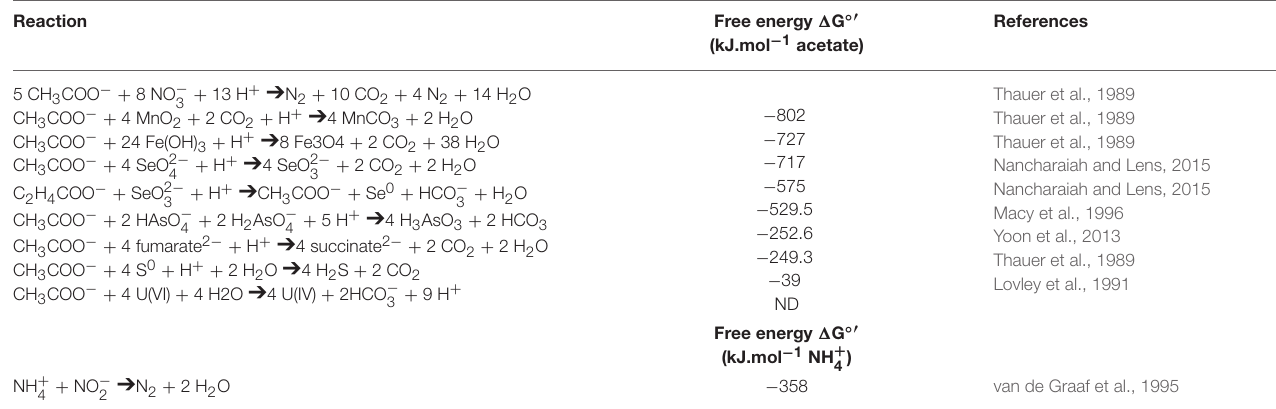
TABLE 2 | Comparison of free energy 1 G ◦′ for various TEAs coupled to acetate oxidation and associated reactions.